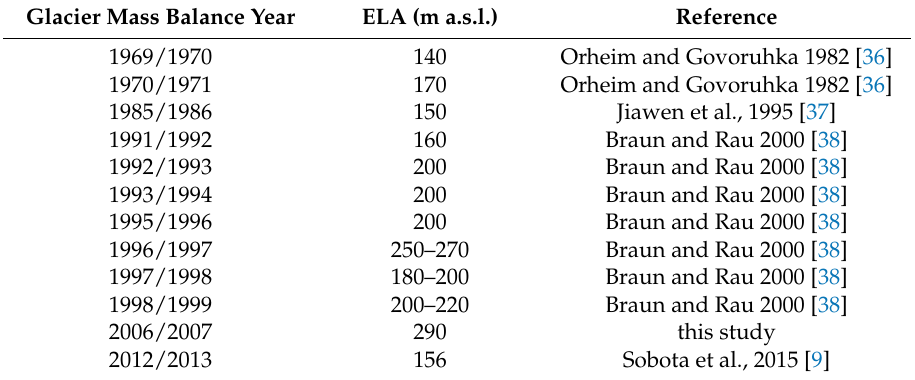
Table 2. The changes in the Equilibrium-Line Altitude (ELA) heights on King George Island. Glacier Mass Balance